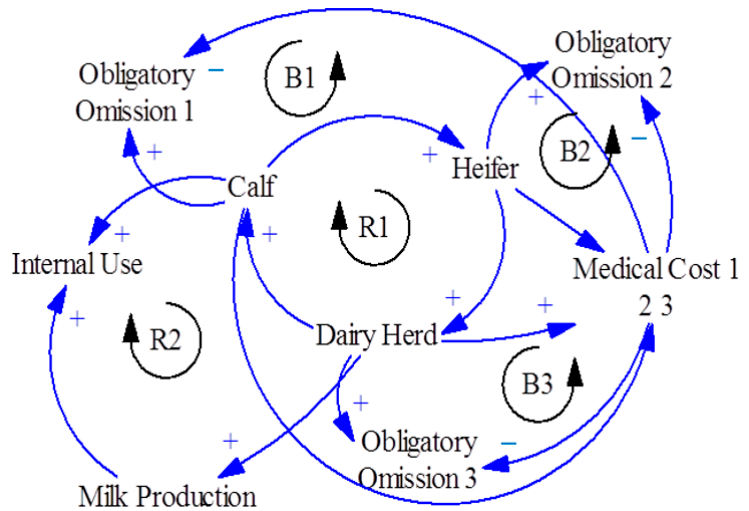
Figure 1. Causal diagram of Fereidan Ahrar ranch. The different balance loops and reinforcing loops are described separately.